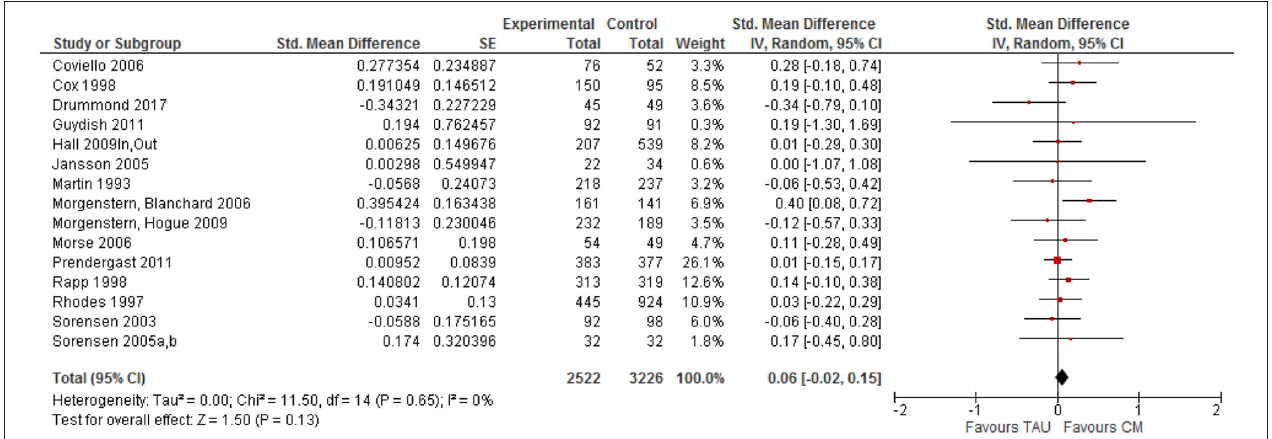
FIGURE 5 | Forest plot of Case management vs. TAU: Personal functioning outcomes.